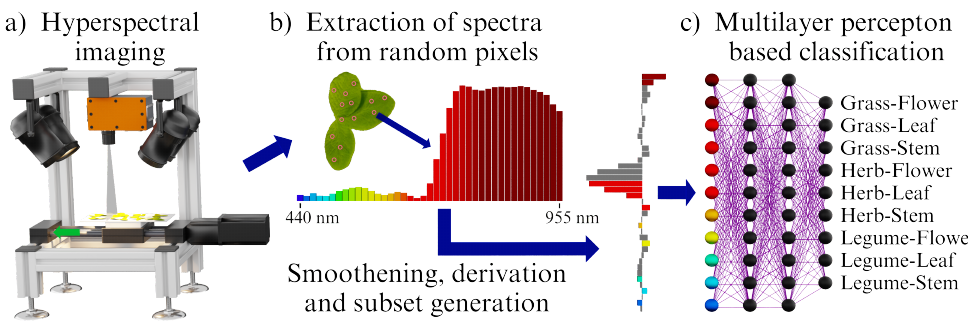
Figure 1. Schematic workflow from hyperspectral data acquisition ( a ) to data preprocessing ( b ) and to the training and validation of a multilayer perceptron (MLP) ( c ). Here, all sampled classed are